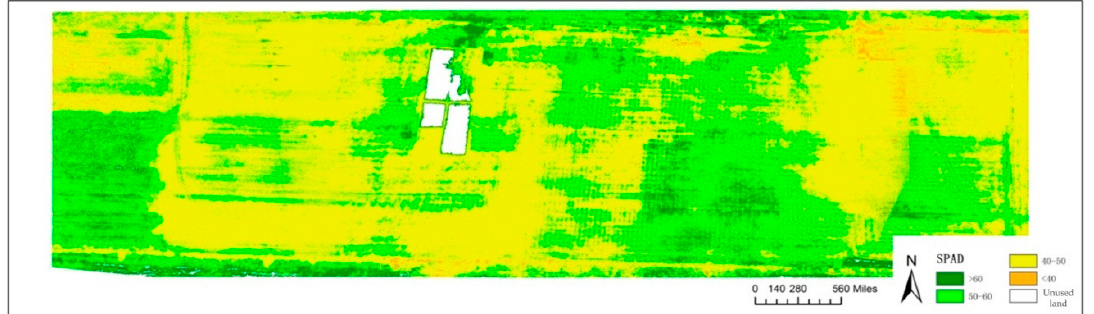
Figure 4. The spatial distribution map of SPAD values in part of the core test area. Table 11. The proportion of areas with SPAD values in different ranges (without non-agricultural land). Ranges of